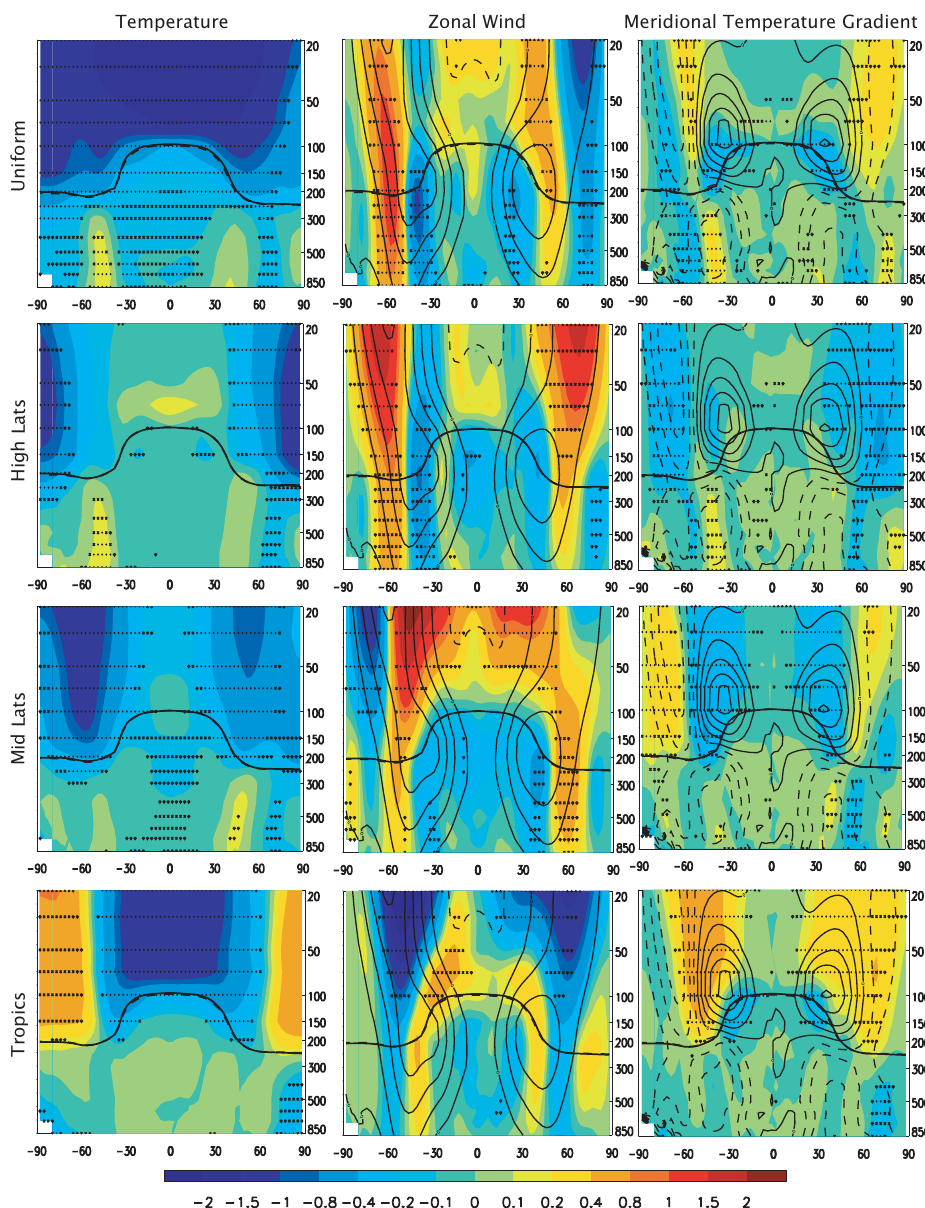
Fig. 2. Zonal annual mean (left) temperature, (center) zonal wind and (right) meridional temperature gradient response for 10PLO3 at (top) all latitudes, (middle top) high latitudes, (middle bottom) mid-latitudes and (bottom) low latitudes. Also shown is the tropopause pressure for the (dashed) control and (solid) experiment. Symbols represent significance at the 90% (diamond); 95% (cross) and 99% (dot) confidence level. Climatological U ( T y ) contour interval is 10 m s − 1 (2 × 10 − 3 K km − 1 ) with negative values dashed. T units are